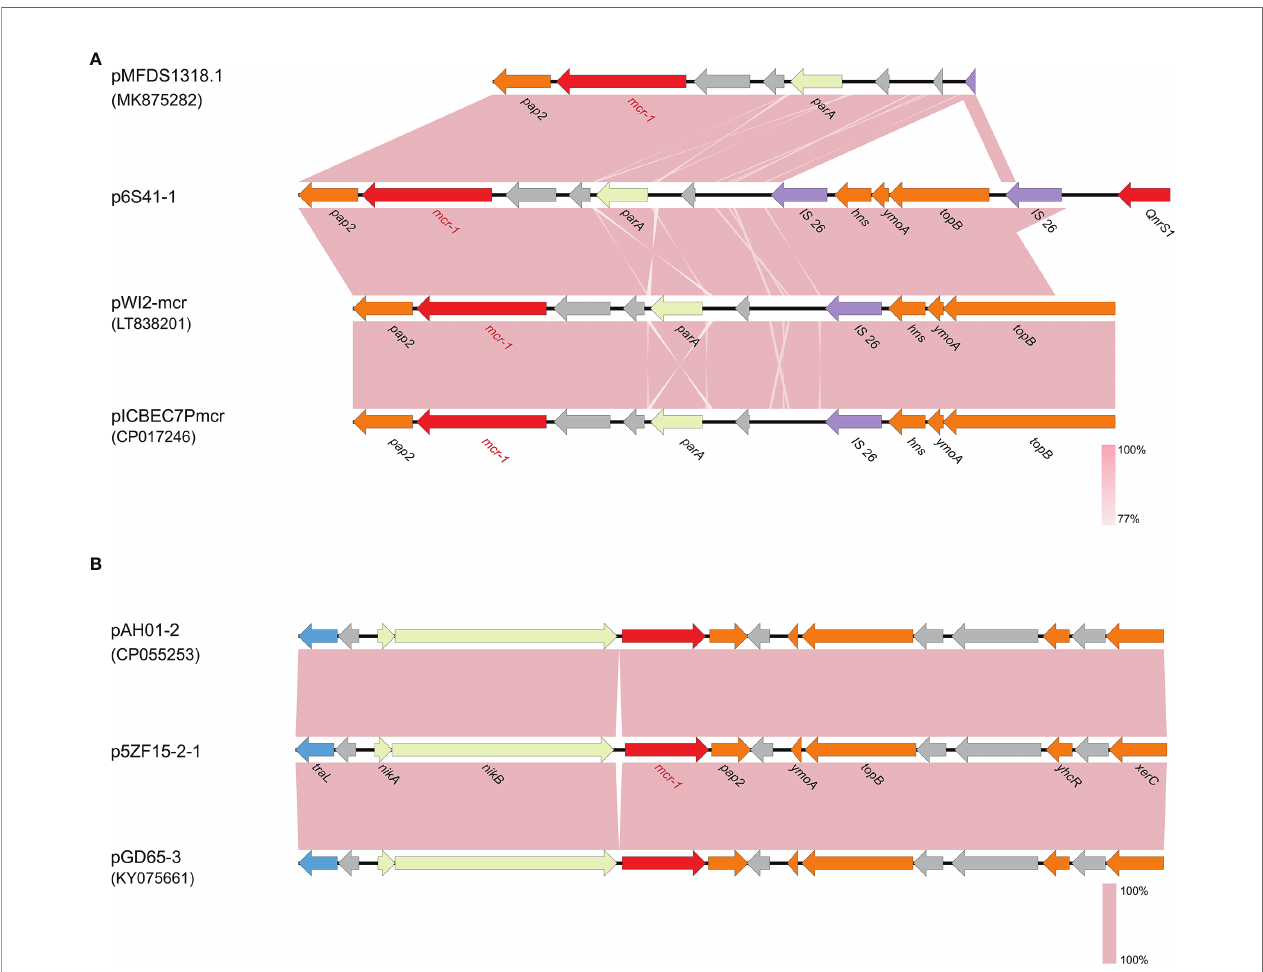
FIGURE 2 | The genetic context of mcr-1 gene on p6S41-1 and p5ZF15-2-1. (A) Comparison of genes surrounding mcr-1 on p6S41-1, pMFDS1318.1 (accession number: MK875282), pWI2-mcr (accession number: LT838201) and pICBEC7Pmcr (accession number: CP017246). (B) Comparison of genes surrounding mcr-1 on p5ZF15-2-1, pAH01-2 (accession number: CP055253) and pGD65-3 (accession number: KY075661). Open reading frames (ORFs) are shown as arrows and indicated according to their putative functions. Purple indicates genes related to mobile elements, red indicates genes related to drug resistance, light yellow indicates genes related to plasmid stability, blue indicates genes involved in conjugation and orange represents other functional genes. Hypothetical protein encoded genes are colored by grey. Regions with a high degree of homology are indicated by pink